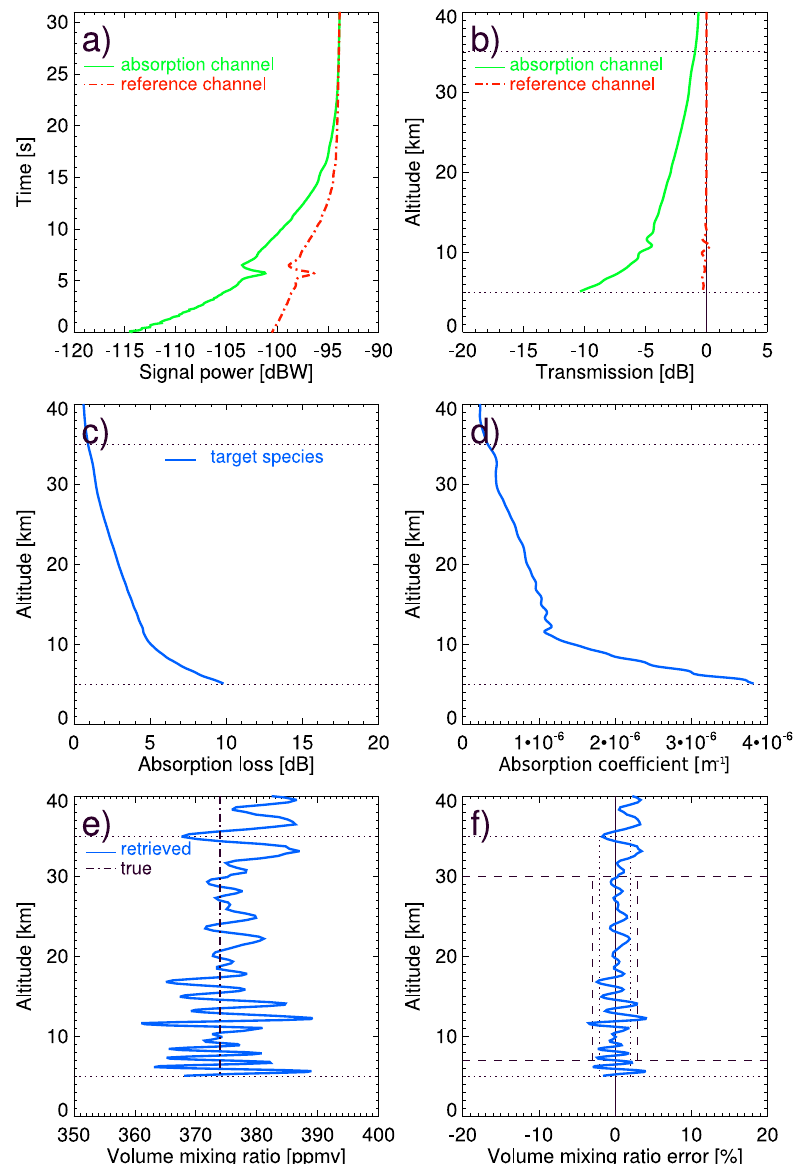
Fig. 4. Illustration of the single-line trace species retrieval (SSR) algorithm for the single-line species 12 CO 2 . (a) LIO input profiles, simulated signal powers for the 12 CO 2 absorption (green solid line) and reference (red dashed-dotted line) channel as a function of time. (b) Transmission profiles for the two channels after defocusing and spreading correction and allocation to the IR altitude grid. (c) 12 CO 2 absorption loss profile after absorption-reference channel differencing and correction for all background effects. (d) 12 CO 2 absorption coefficient profile after Abel transform retrieval. (e) Retrieved (blue solid) and true (black dashed-dotted) 12 CO 2 volume mixing ratio (VMR) profile. (f) 12 CO 2 VMR retrieval error profile (retrieved-minus-true relative to true). The horizontal and vertical dotted/dashed lines – especially used in panel (f) – indicate the target/threshold observational requirements for altitude domain and accuracy for the LMIO mission concept (Larsen et al., 2009; Kirchengast et al.,